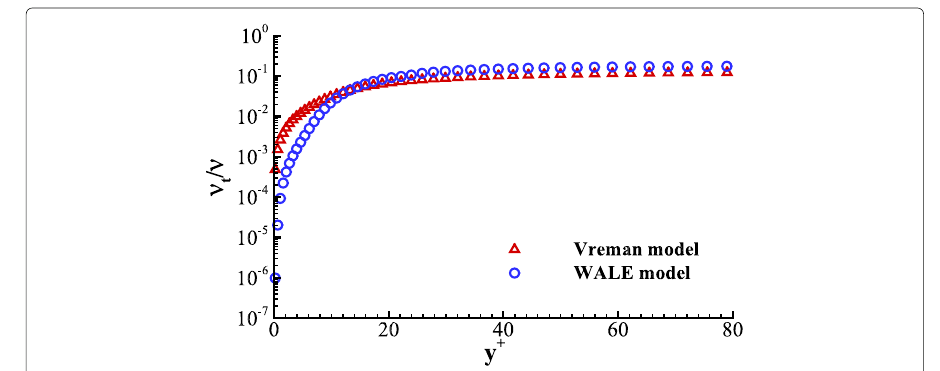
Fig. 14 The ν t /ν in the near wall region for the turbulent plane Couette flow at Re τ =